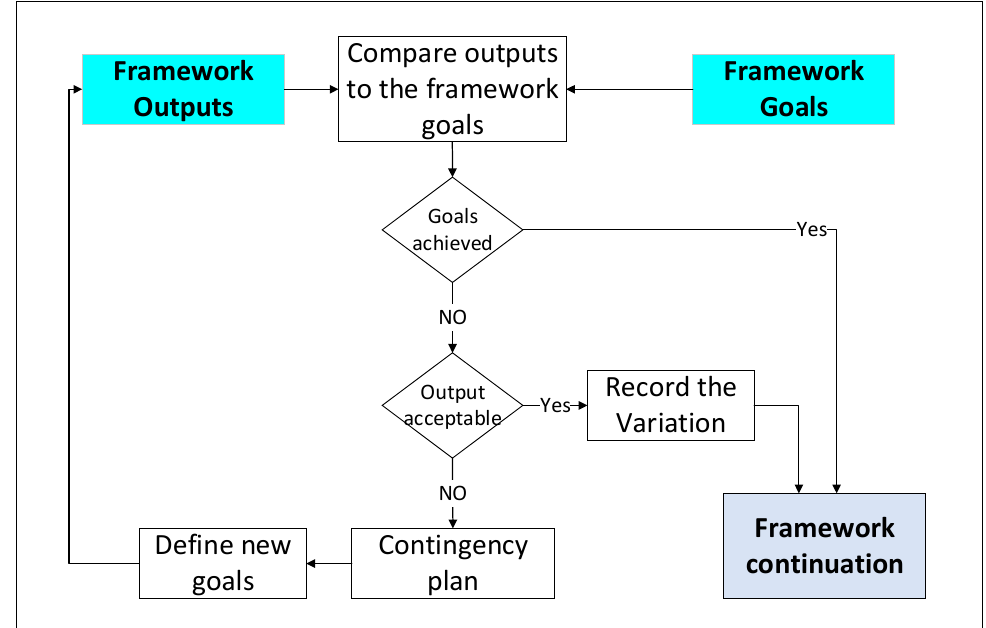
Figure 5. Evaluation of the framework goals.